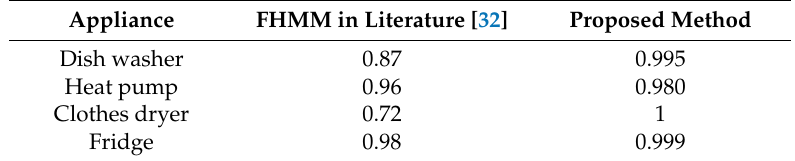
Table 5. F-score values compared with the factorial hidden Markov models (FHMM) method.